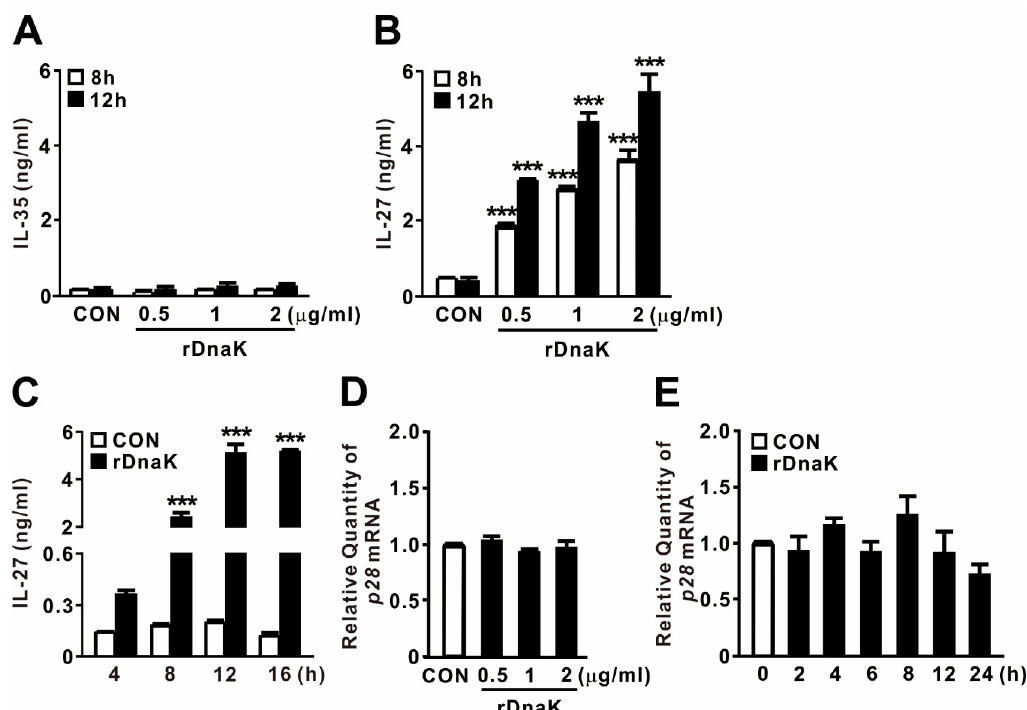
Figure 3. DnaK-induced EBI3 is involved in formation of IL-27. ( A , B ) dTHP-1 cells were treated with rDnaK at the indicated concentrations for the indicated times. ( C ) dTHP-1 cells were treated with 0.5 μ g/mL rDnaK for the indicated times. ( D , E ) dTHP-1 cells were treated with the indicated concentrations of rDnaK for 4 h ( D ) and 0.5 μ g/mL rDnaK for the indicated times ( E ). After treatment, protein levels of IL-35 and IL-27 released from dTHP-1 cells were measured by ELISA ( A – C ), and the p28 mRNA level was quantified by qRT-PCR ( D , E ). Data are expressed as means ± SD ( n = 3). ***, p < 0.001 vs. CON.